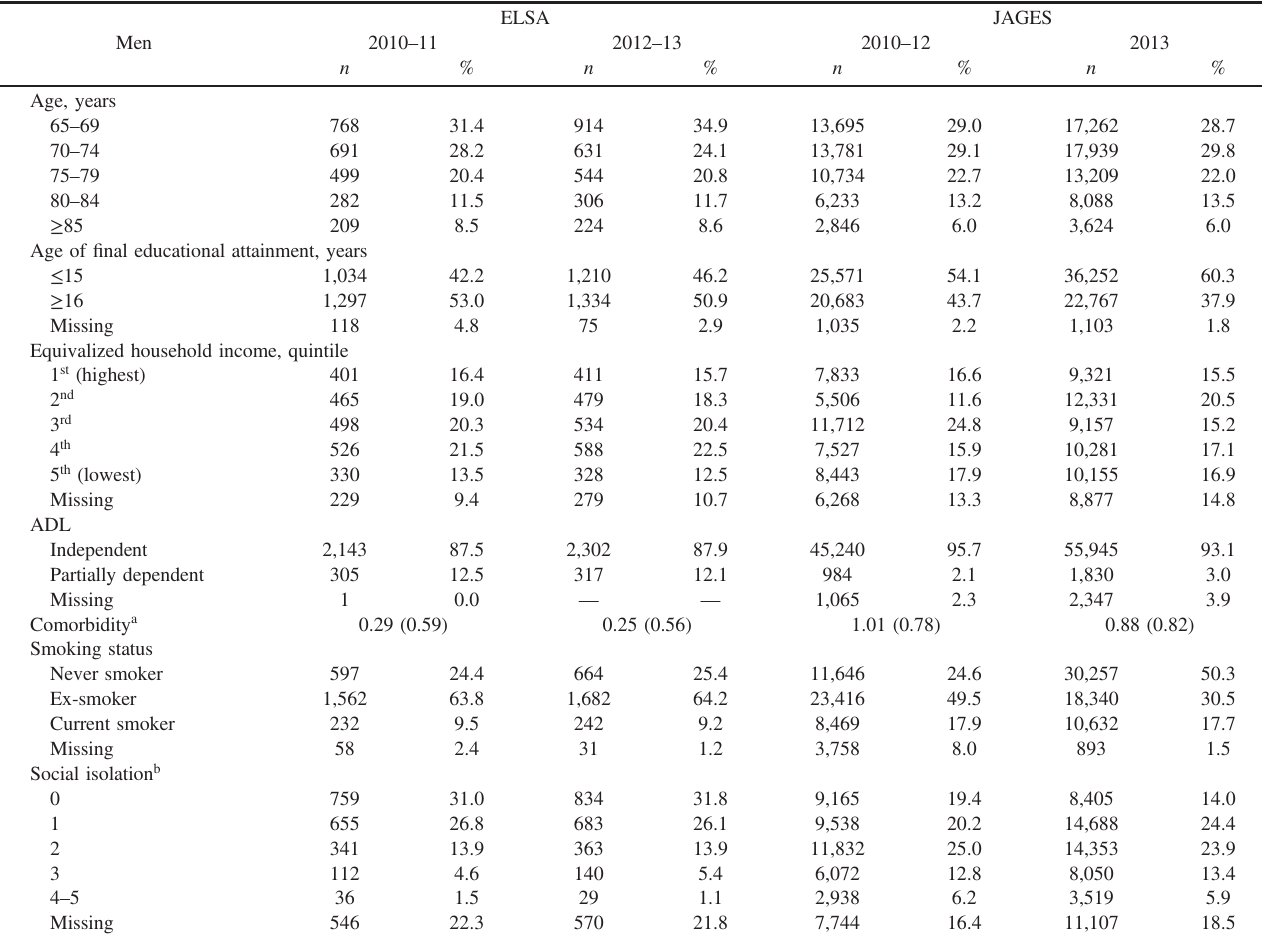
Table 1. Sociodemographic characteristics of men in ELSA and JAGES by survey year